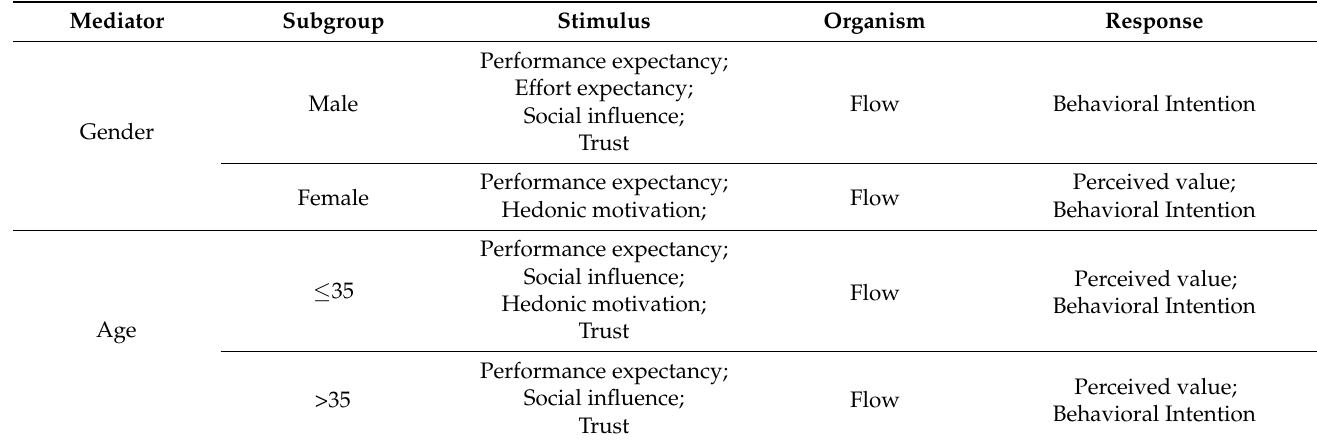
Table 10. The significant determinants of each